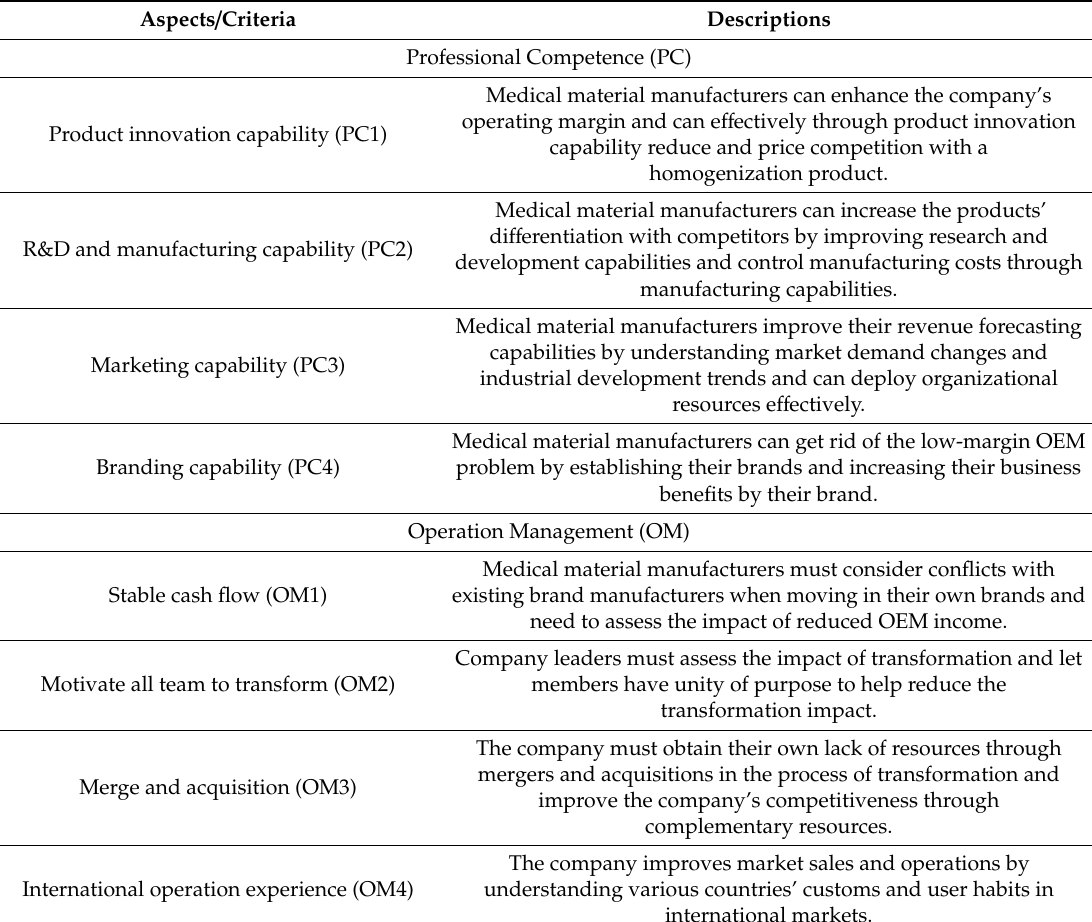
Table 1. The descriptions of aspects / criteria for the digital transformation of Med-Tech enterprises. Aspects /